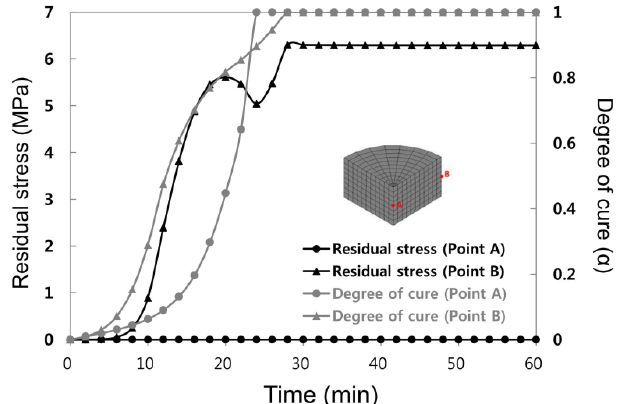
Figure 7. Residual stress evolution and degree of cure during the third step curing at Points A and